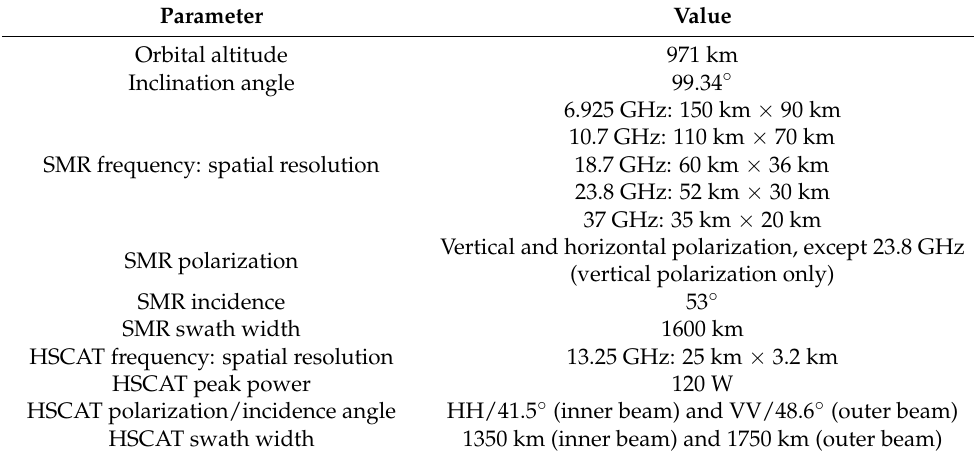
Table 1. Main specifications for SMR and